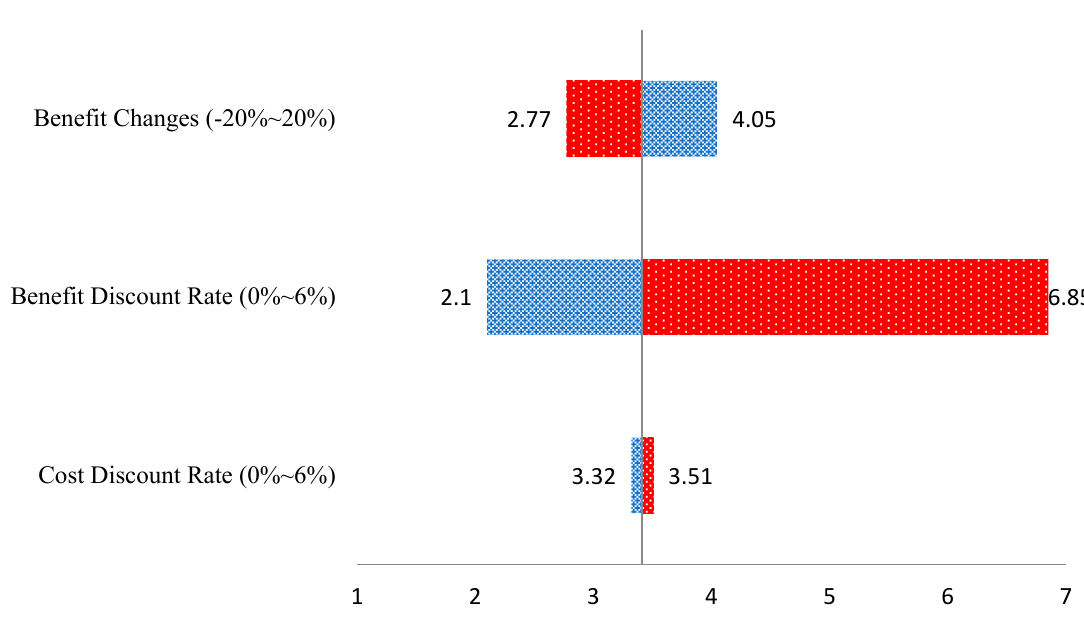
Figure 1. The changes of BCRs from the sensitivity analysis.